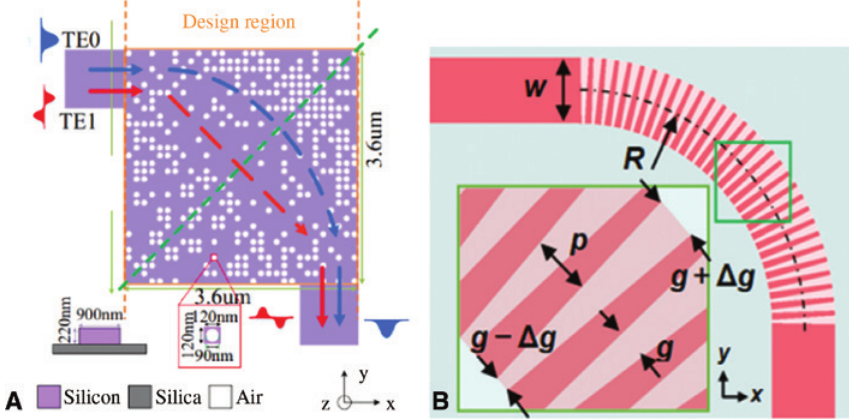
Figure 9: On-chip multimode waveguide bends realized with modified effective refractive index profile in the bent section. (A) A two-mode waveguide bend consisting of a pair of equivalent Y-junctions designed with nanoholes [99]. (B) Configuration of a multimode waveguide bend with subwavelength structures